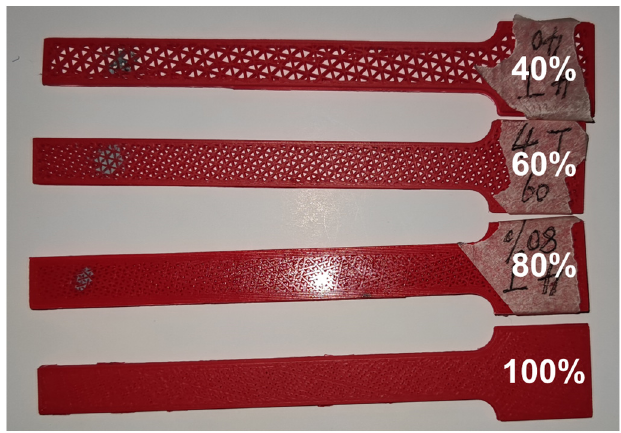
Figure 12. The specimens with different infill densities (0.4 mm nozzle size and triangle pattern).